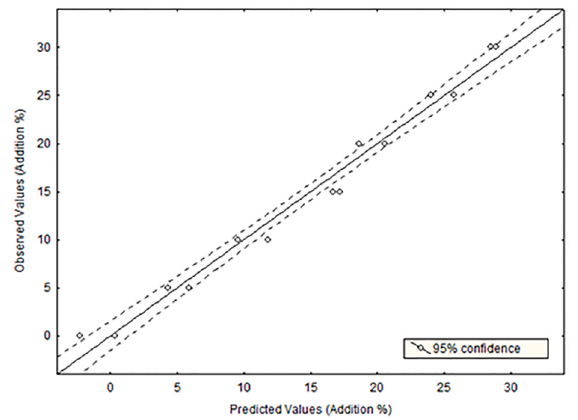
Figure 4. Prediction of adulteration percentage applying stepwise multiple linear regression to virgin olive oil and refined hazelnut oil mixtures.